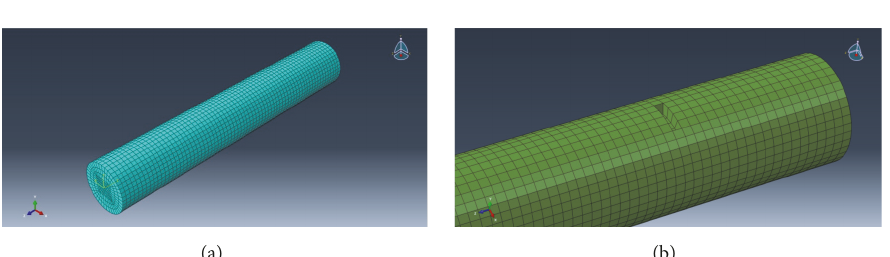
Figure 4: (a) Slip ring and (b) crack.